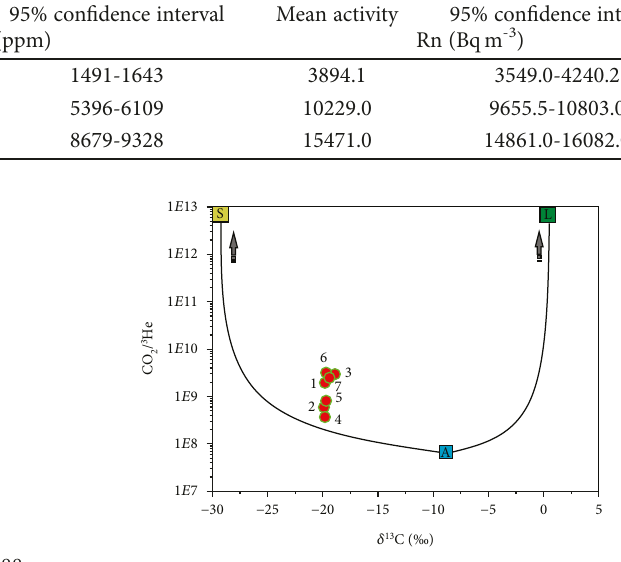
concentrations in the 388 2